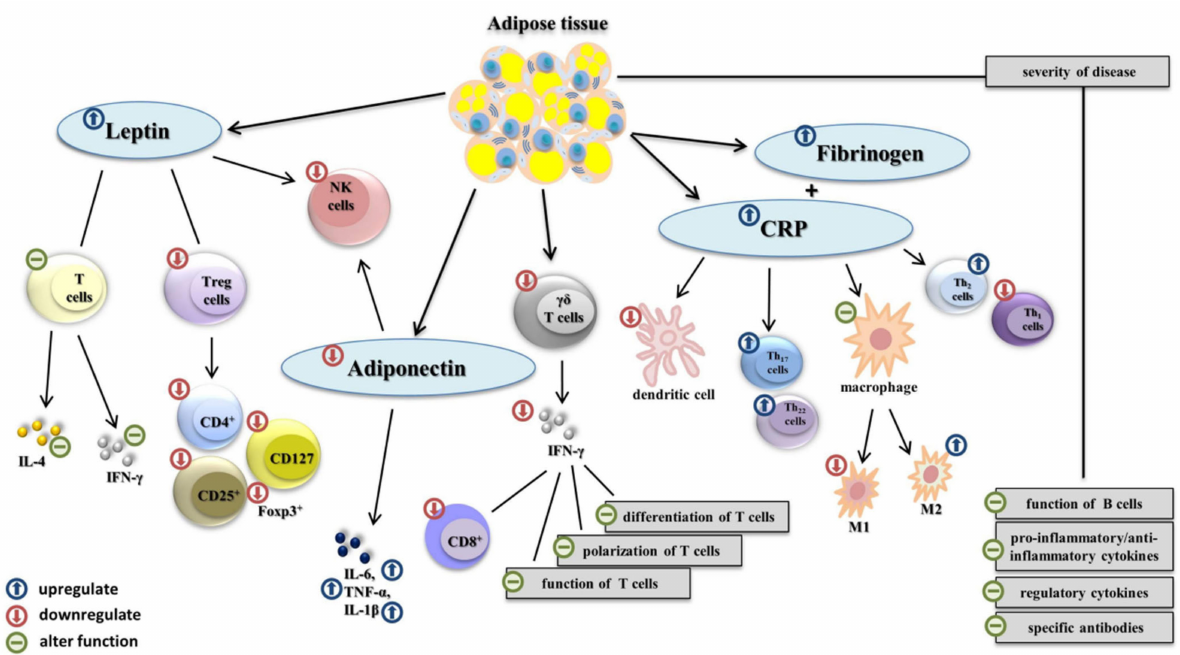
Figure 1. The impact of obesity on the immune system. In obese individuals, overaccumulated white adipose tissue overexpress adipokines such as leptin adiponectin, C-reactive protein (CRP), and fibrinogen. The leptin receptor is expressed on the surface of T lymphocytes and alters the function of pro-inflammatory IFN- γ and IL-4. Hyperleptinemia is associated with decreased activity of NK cells and lower level of Treg, which lead to a lower amount of sufficient CD4 + , CD25 + , and CD127 markers and Foxp3 + transcription factor. A decreased concentration of adiponectin alters the function of NK cells. Pro-inflammatory cytokines TNF- α , IL-1 β , IL-6, and CCL2 are constantly overexpressed. Lower levels of γδ T cells lead to a reduced production of pro-inflammatory IFN- γ , and alter the adaptive immunity response. Overexpression of CRP impairs the homeostasis between Th1 and Th2 cell subsets, increases the activity of Th17 and Th22, decreases the level of M1 macrophages (M1), increases the level of M2 macrophages (M2), and decreases the number of dendritic cells.